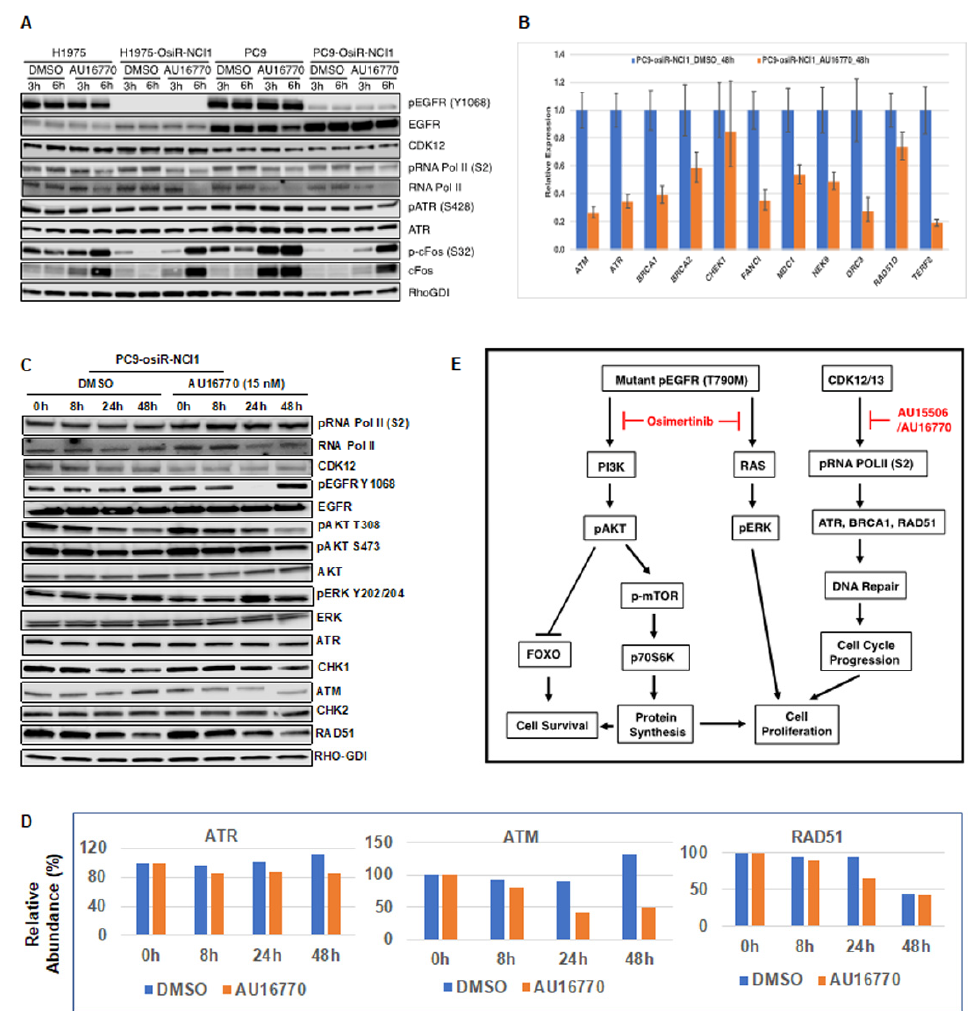
Figure 6. Identification of cellular components affected by AU-16770. ( A ) H1975/H1975-osiR-NCI1 and PC9/PC9-osiR-NCI1 cells were treated with 100 nM AU-16770 for three and six hours and then lysed in RIPA buffer. Cell extracts were immunoblotted with phospho-specific or total antibodies against EGFR, AKT, ERK, RNA pol II, ATR, FOS, and CDK12. RhoGDI-specific antibodies were used for loading control. ( B ) Expression analysis of genes having long transcripts. mRNA was isolated from PC9-osiR cells in triplicate following treatment with DMSO (vehicle) or AU-16770 for 24 h. Relative expression of ATR, ATM, BRCA1, BRCA2, FANC1, MDC1, NEK9, ORC3, RAD51, CHEK, and TERF2 genes were analyzed by quantitative PCR using GAPDH as a reference gene. ( C ) Immunoblot analysis of extracts from PC9-osiR cells treated with DMSO or AU-16770 for 0 h, 8 h, 24 h, and 48 h with antibodies against EGFR signaling components, cell-cycle proteins, and DNA damage repair pathway proteins as indicated. AU-16770 specifically affected AKT survival pathway and DNA repair mechanisms. ( D ) Relative intensities of ATR, ATM, and RAD51 in PC9-osiR-NCI1 cells quantified from Figure 6C using ImageJ software. Intensities of above proteins at 0 h of drug treatment were represented as 100%. ( E ) Model depicting the combinatorial effect of osimertinib and CDK12 inhibitor (AU-15506 or AU-16770) in suppressing DNA replication/transcription of proliferation/survival-specific genes leading to inhibition of cell-cycle progression and cell proliferation in osimertinib-resistant cells. Osimertinib potentially upregulates receptor tyrosine kinases (RTKs) in osimertinib-resistant cells, potentially leading to sustained pERK and pAKT activity which are key to cell survival and proliferation. Inhibition of the CDK12 pathway by AU-15506/AU-16770 may lead to reduction in cFOS, ATR, BRCA1, and RAD51 activities and subsequent inhibition of cell-cycle pathway and cell